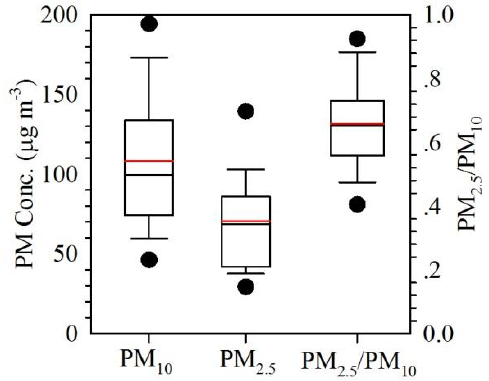
Figure 2. Box-circles plots of the PM 2.5 and PM 10 concentration and the mass ratio of PM 2.5 /PM 10 . The box boundaries represent the 25th and 75th percentile, and the black and red horizontal lines are the median and the average, respectively.